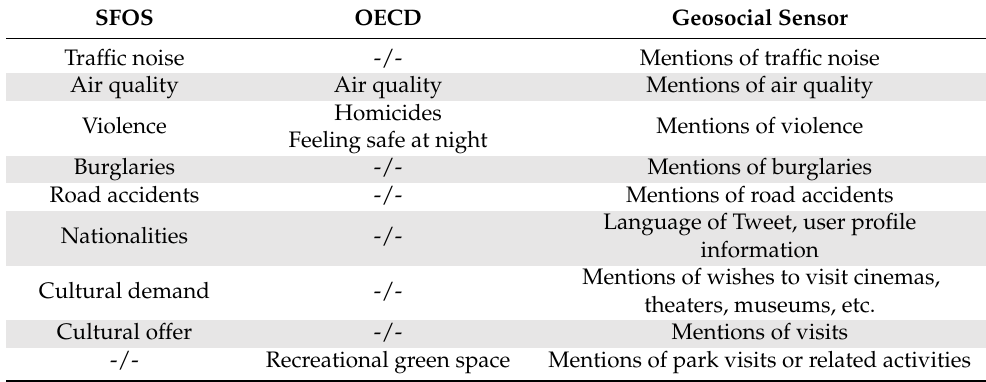
Table 7. Potential quality of life indicators for geosocial